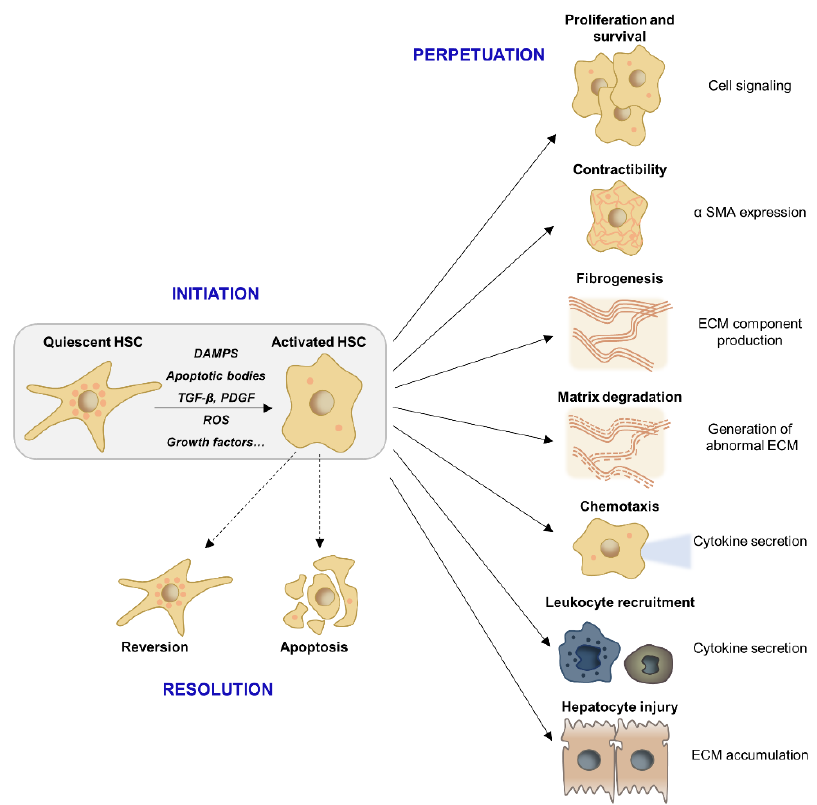
Figure 2. HSC activation and downstream pro-fibrogenic responses. Following the initial event of HSC activation, non-parenchymal cell directed pro- or anti-fibrogenic responses determine whether activated HSCs either transit into spontaneous resolution via reversion and apoptosis or pass into a perpetuated state that results in maintenance of a pro-inflammatory and pro-fibrogenic microenvironment as well as liver degrading ECM accumulation. Abbreviations: α-SMA: α-smooth muscle actin; DAMPS: Damage-associated molecular pattern; ECM: Extracellular matrix; HSC: hepatic stellate cells; PDGF: Platelet-derived growth factor; ROS: Reactive oxygen species; TGF-β: Transforming growth factor β.